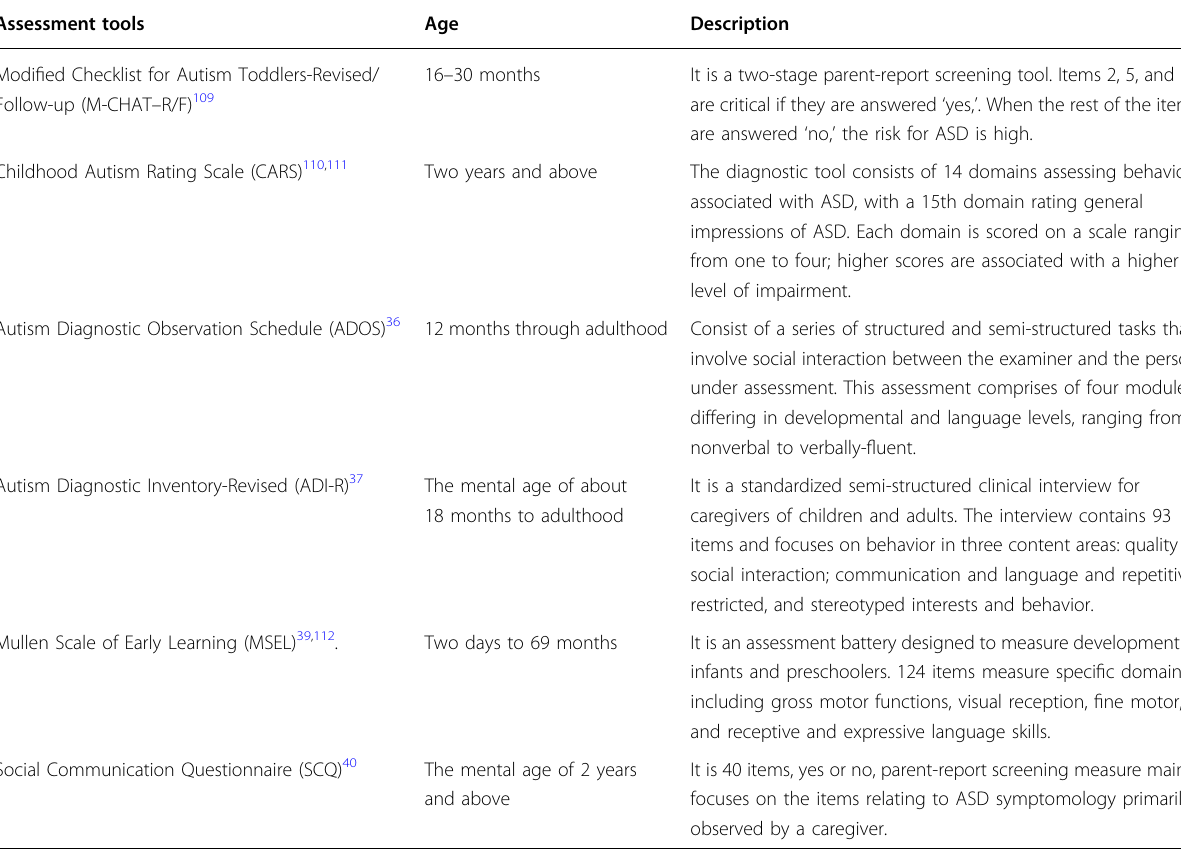
Table 1 Developmental and behavioral assessment tools used to characterize the features of children with autism. Assessment